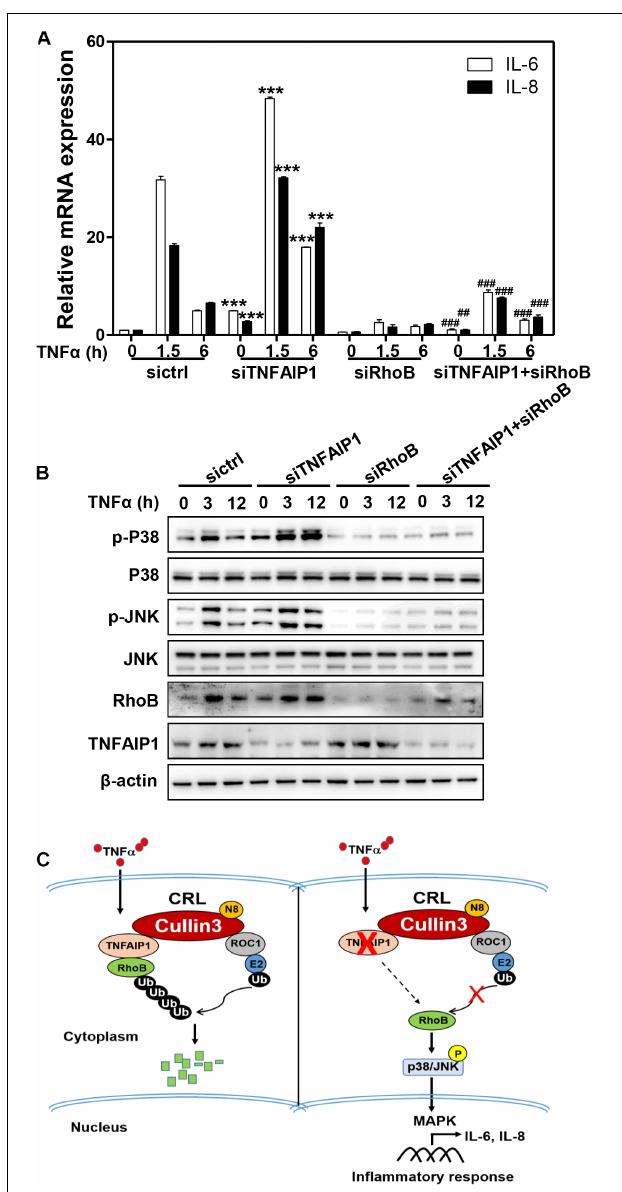
FIGURE 6 | Downregulation of TNFAIP1 triggered inflammatory response in HCC cells via blocking the degradation of RhoB upon TNF α stimulation. (A) Silencing TNFAIP1 prolonged the IL-6 and IL-8 transcripts in Huh7 cells upon TNF α treatment, and RhoB knockdown rescued the siTNFAIP1-induced upregulation of IL-6 and IL-8. Huh7 cells were transfected with indicated combination of ctrl (control), TNFAIP1 and RhoB siRNA for 96 h and treated with 20 ng/mL TNF α at indicated time, and the transcriptional levels of IL-6 and IL-8 were determined by qPCR analysis. (B) Silencing TNFAIP1 induced the activation of p38/JNK MAPK signaling in Huh7 cells upon TNF α treatment, and knockdown of RhoB reversed the upregulation of phospho-JNK and phospho-p38. Huh7 cells were transfected with indicated combination of ctrl (control), TNFAIP1 and RhoB siRNA for 96 h and treated with 20 ng/mL TNF α at indicated time, and cell lysates were harvested for western blot analysis. (C) Working model. Downregulation of TNFAIP1 induced the activation of p38/JNK MAPK signaling pathway and promoted the transcription of IL-6 and IL-8 via blocking RhoB degradation upon TNF α stimulation. *** P < 0.001 vs. control group; ## P < 0.01 and ### P < 0.001 vs. siTNFAIP1